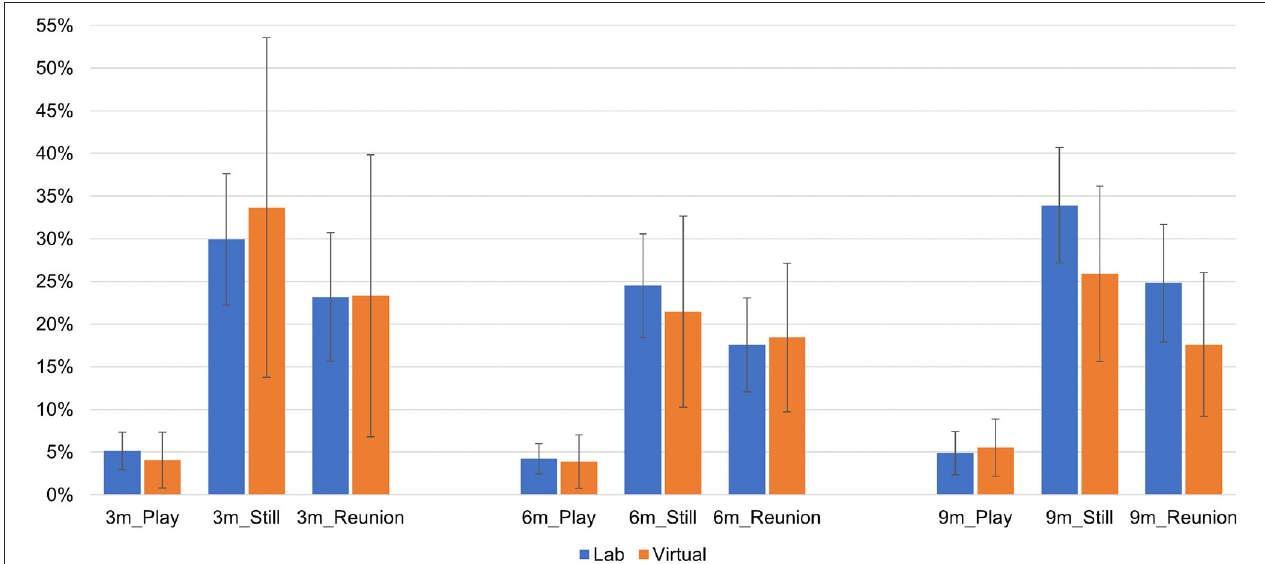
FIGURE 4 | Infant negative affect at each time point as a function of Still Face episode and visit